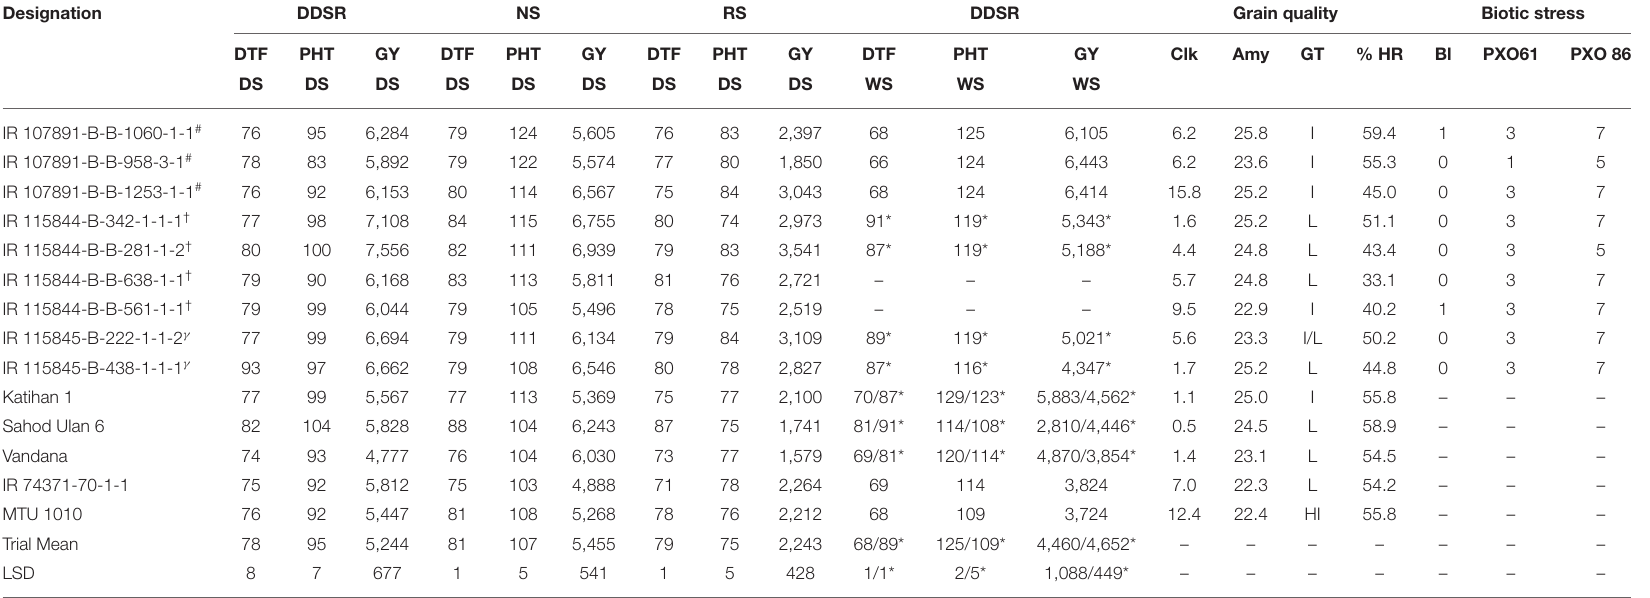
TABLE 8 | Performance of selected promising multi-parent breeding lines over check varieties from a conventional breeding program in advanced yield trials at IRRI,